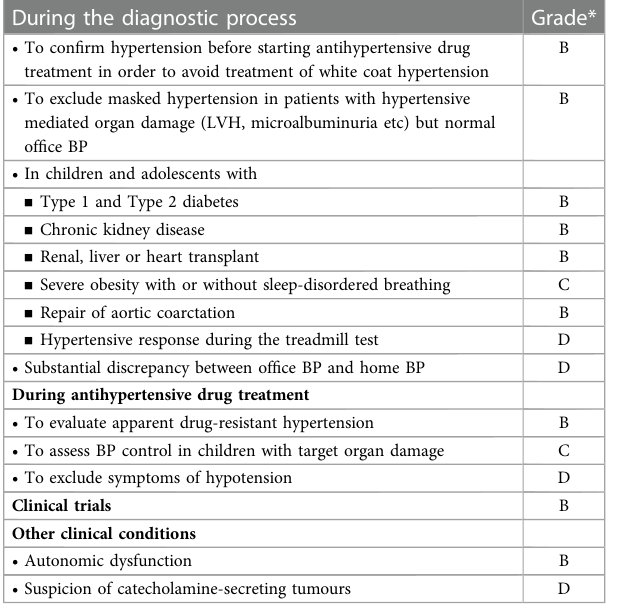
TABLE 5 Indications for 24-h ambulatory blood pressure monitoring. During the diagnostic